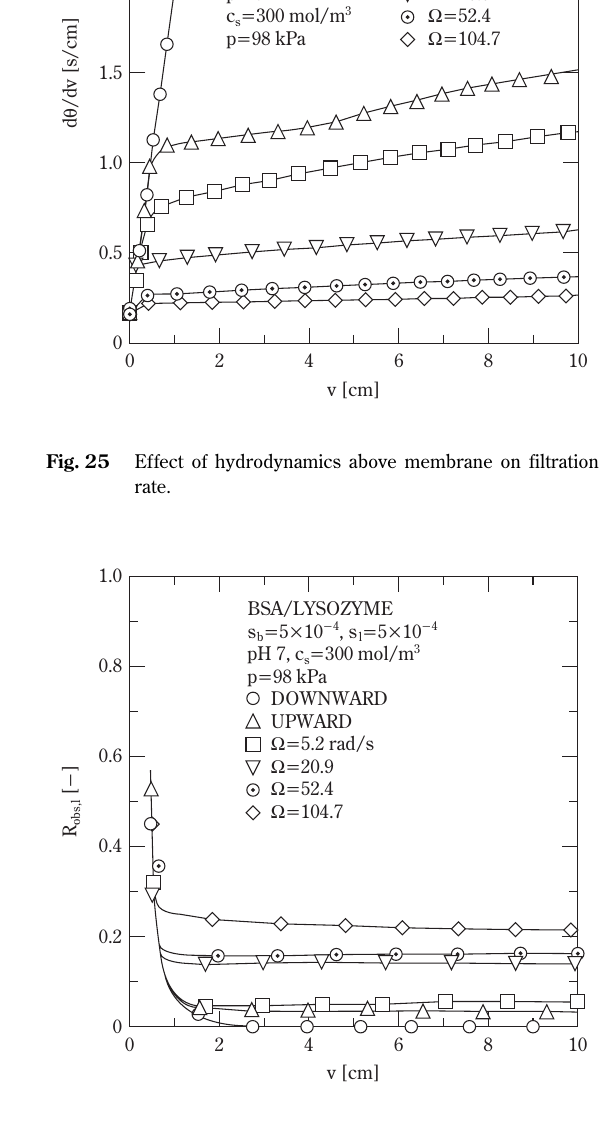
Fig. 26 Effect of hydrodynamics above membrane on apparent lysozyme rejection.